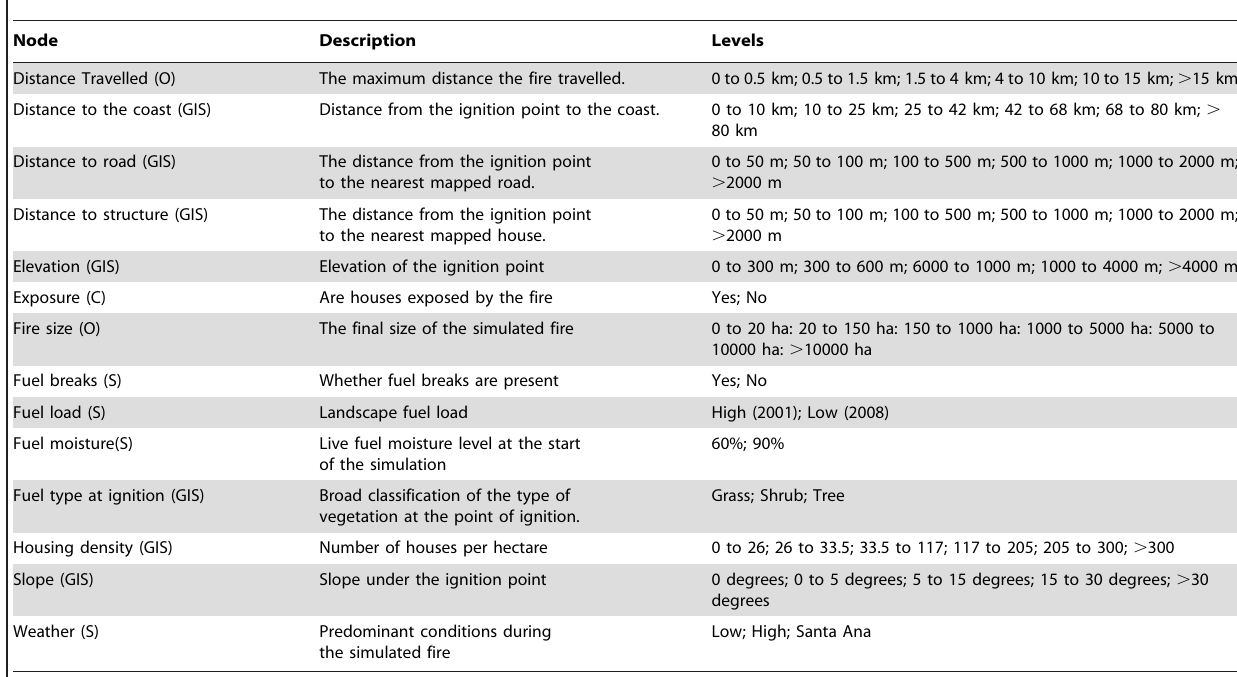
Table 1. Nodes, definitions and states used in the Bayesian Network model.